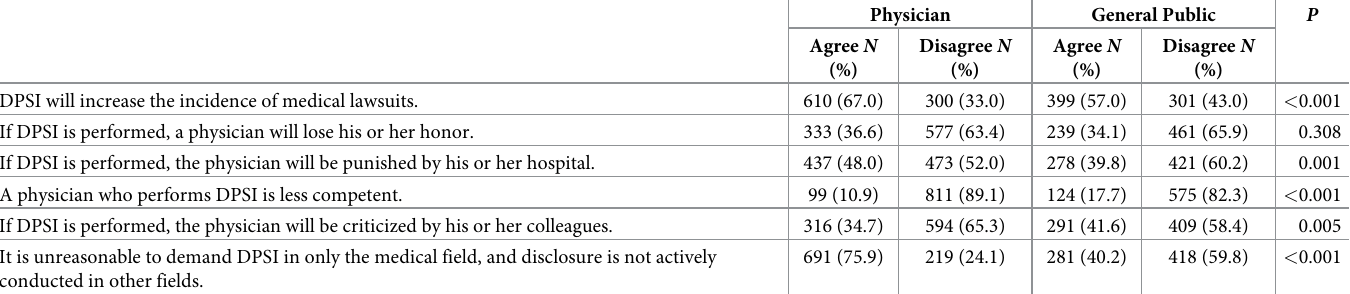
Table 5. Perceptions of barriers to DPSI.